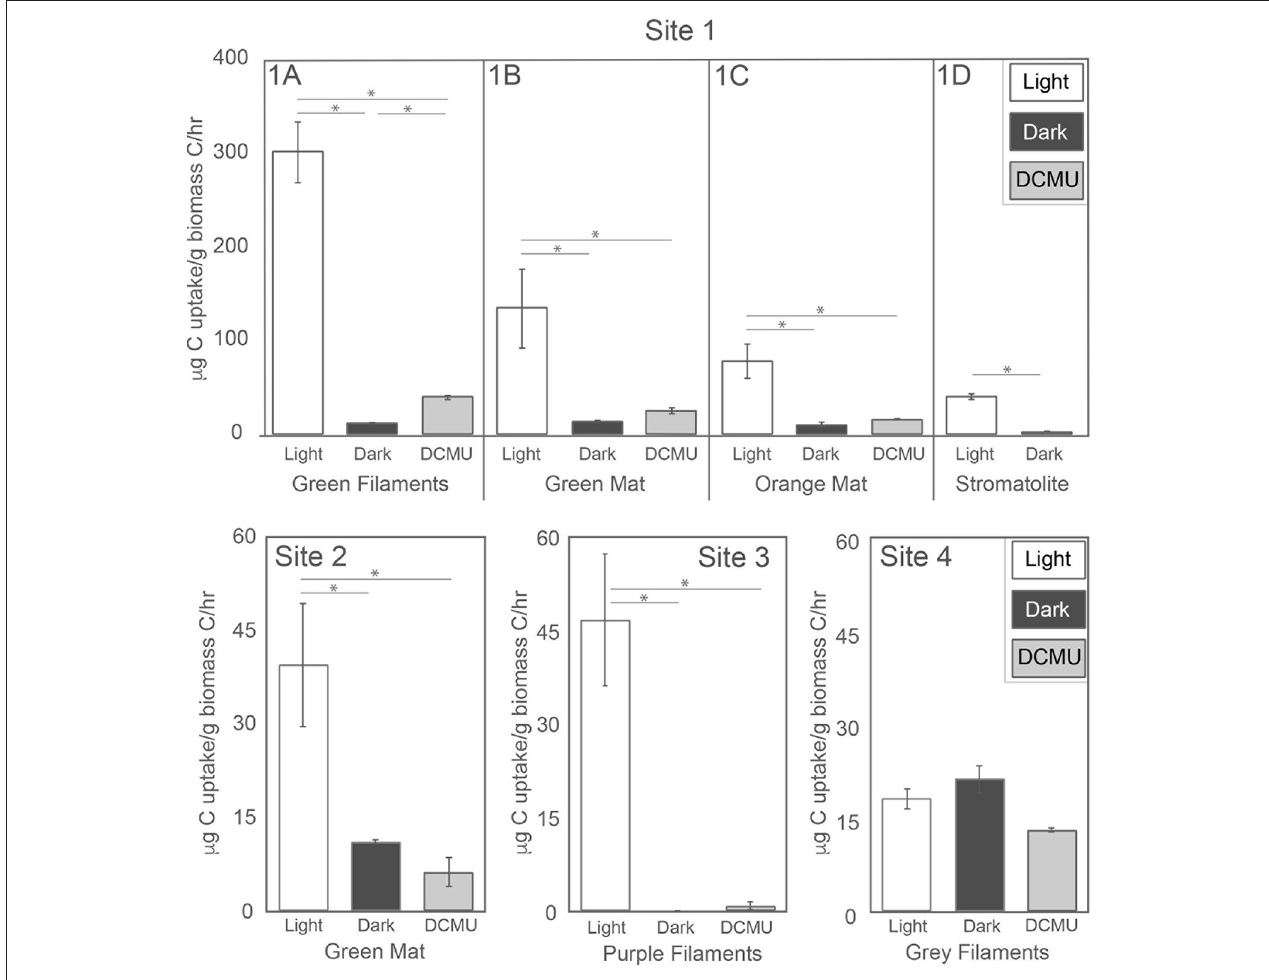
FIGURE 2 | Carbon assimilation rates. Error bars obtained from triplicate measurements. An asterisk indicates rates which are statistically different ( P <